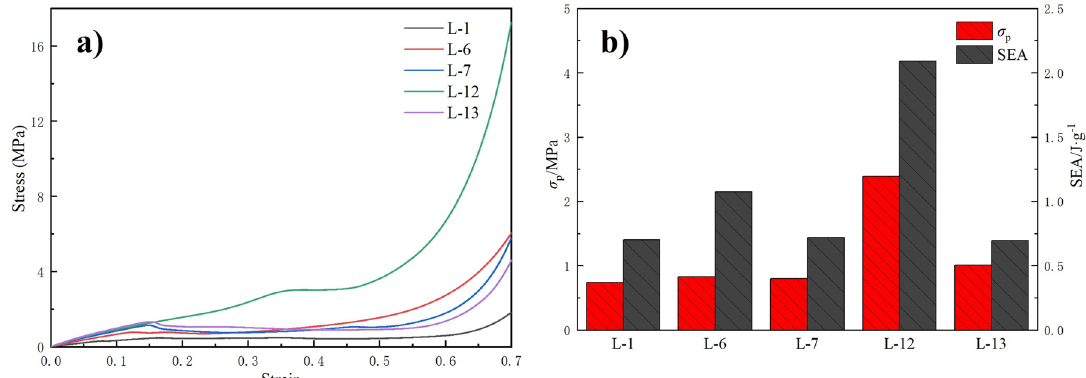
Figure 11. a) Stress-strain curves of different styles and arrangements, b) Platform stress and SEA of different styles and arrangements.